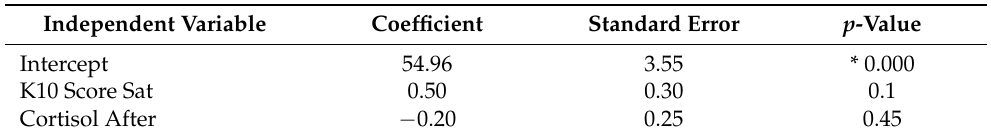
Table 8. Regression result of MASQ Saturday scores as the dependent variable and K10 Saturday scores and saliva cortisol levels after exercise (independent variables). * p <